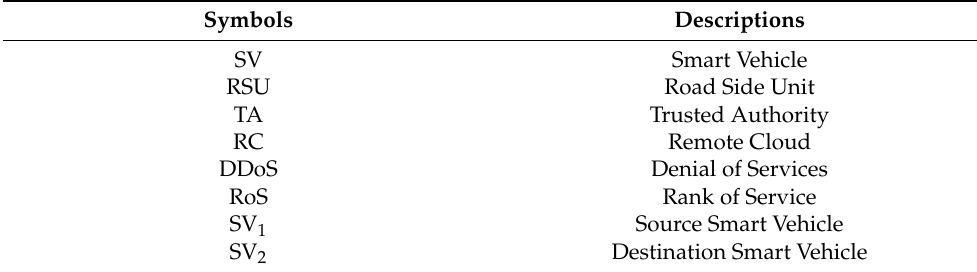
Table 2. Symbols and Descriptions.